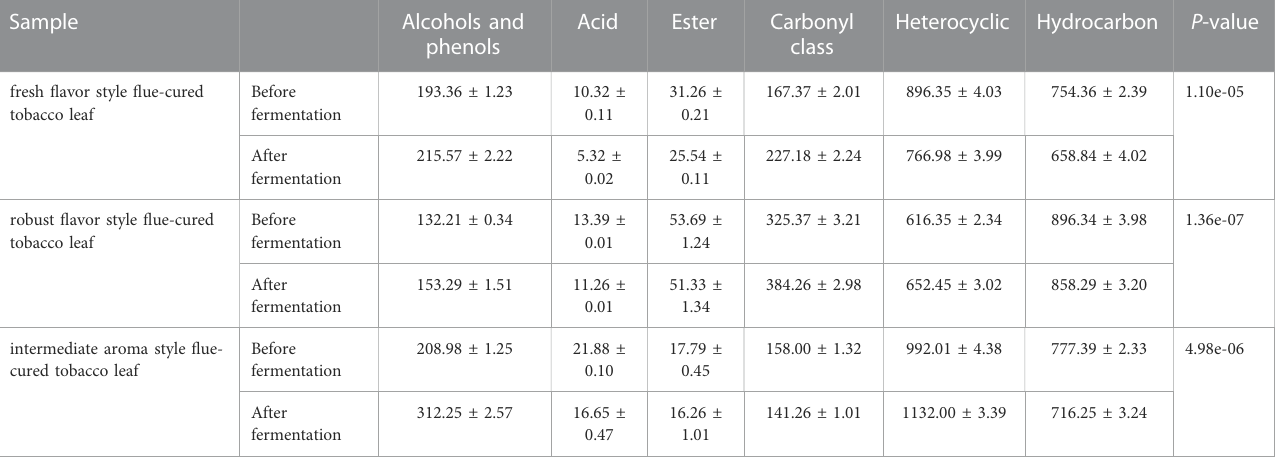
TABLE 6 Changes of volatile components in tobacco leaves treated by strain F7# (ug/g). Sample Alcohols and